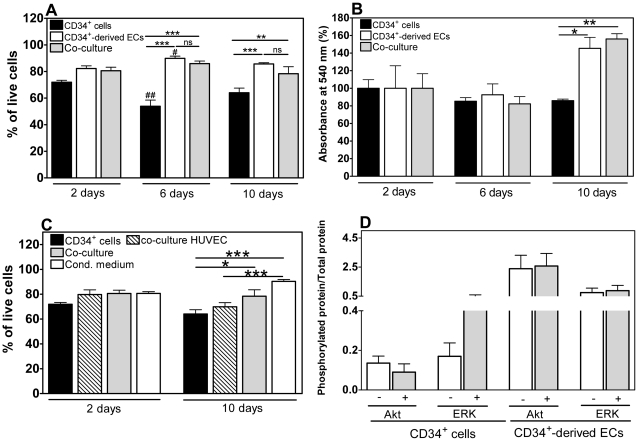
Viability of encapsulated cells.A) Viability of encapsulated cells, as assessed by a LIVE/DEAD assay. Results are average ± SD, n = 3. B) Mitochondrial metabolic activity of encapsulated cells. Results are average ± SD, n = 6. Each absorbance at 540 nm was normalized by day 2 absorbance. C) Viability of encapsulated cells, as quantified by a LIVE/DEAD assay. Results are average ± SD, n = 3. In all figures, * denote statistical significance within time group: * P<0.05, **P<0.01, *** P<0.001. # denotes statistical significance between time groups comparing the respective control/treatment groups: # P<0.05, ## P<0.01. D) Phosphorylated Akt/total Akt and phosphorylated ERK/total ERK ratios assessed by a Bio-Plex phosphoprotein detection assay. Results are average ± SD, n = 3.